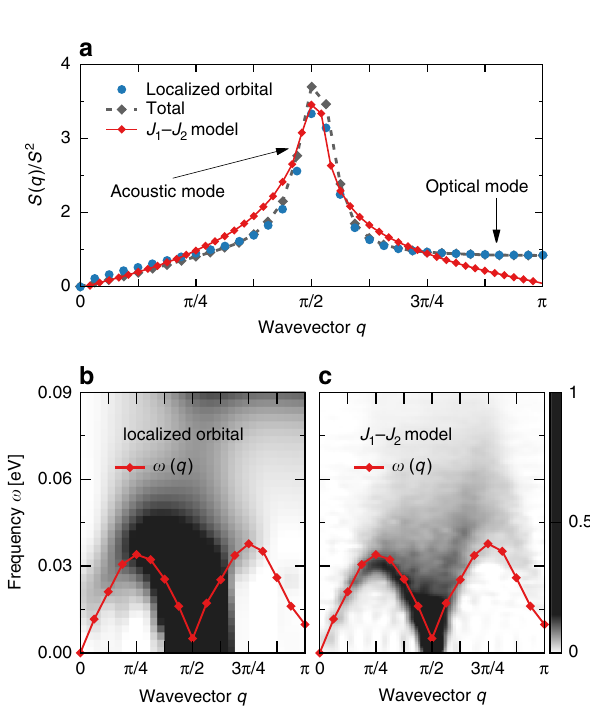
Fig. 5 Comparison with the J 1 – J 2 model. a Comparison of the static SSF S ( q ) corresponding to the multi-orbital system vs results for the J 1 – J 2 model with J J = 1, calculated for L = 32 and L = 48, respectively. S ( q ) is normalized 2 /| 1 | by the local magnetic moment squared S 2 = S ( S + 1), where S 2 = 3/4 for the localized orbital and the J 1 – J 2 result, and S 2 = 2 23 for the total SSF. b Acoustic mode of the dynamical SSF within the block-OSMP phase (the same results as in Fig. 2b) compared against the dispersion relation ω ( q ) of the J 1 – J 2 model with | J 1 | = J 2 = 0.6 J eff , where the effective spin-exchange = U . The latter is obtained with the help of energy scale is set to J 4 t 2 22 eff ¼ Lanczos diagonalization on a chain of 32 sites with periodic boundary conditions. c Dynamical SSF of the J 1 – J 2 model with | J 1 | = J 2 = 0.6 J eff as calculated using DMRG for a L = 48